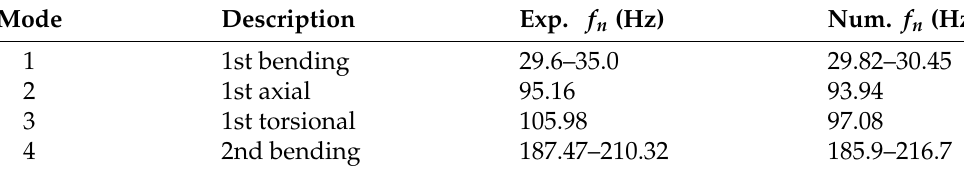
Figure A1. ( A ) Spring experimental setup, ( B ) numerical bending mode shape. Table A1. Experimental and numerical natural frequencies of the fixed–free